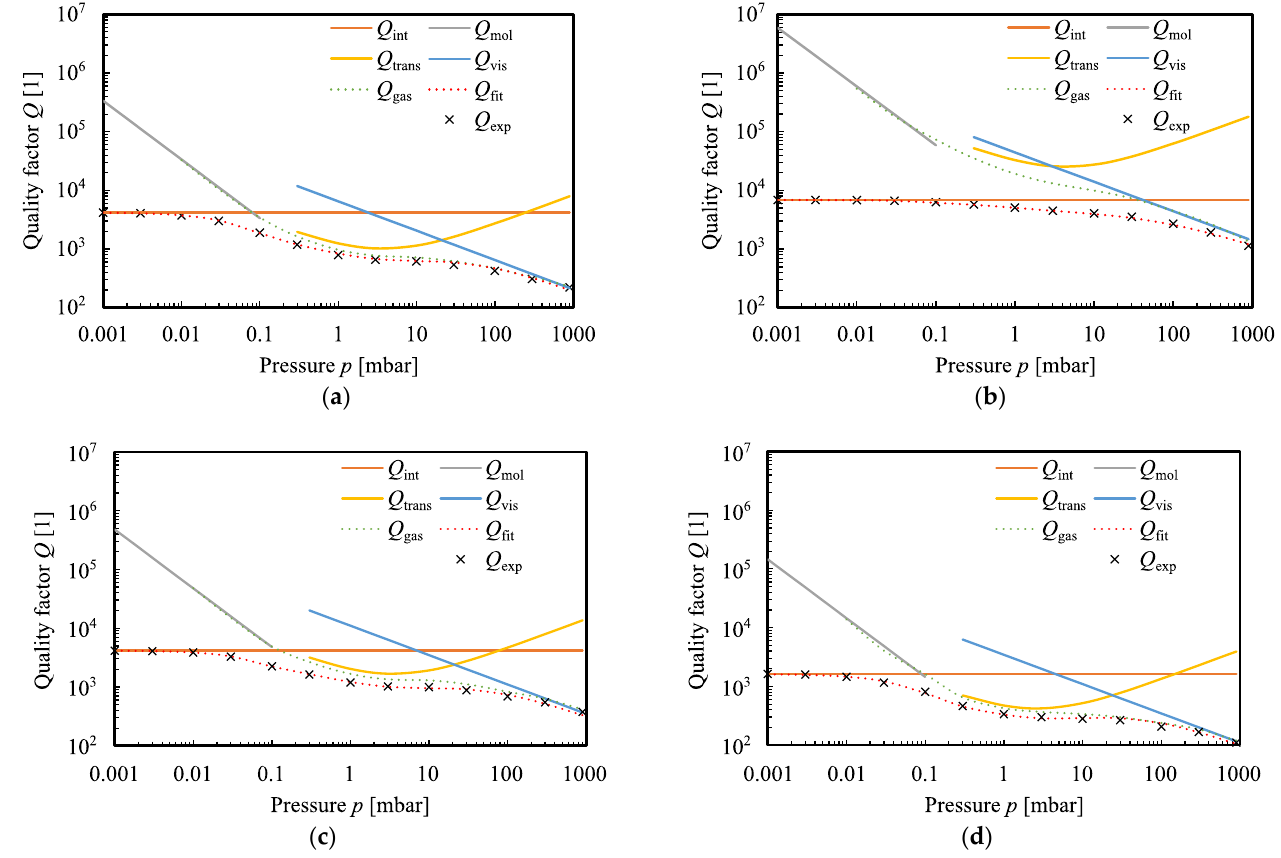
Figure 3. Reconstruction of the experimentally-measured quality factor plot Q exp as function of the ambient pressure. The total quality factor Q fit is composed of the individual damping mechanisms and shows very good agreement over the entire range from molecular to viscous flow regime for the 1st BM ( a ) and for the 3rd BM ( b ) of MEMS oscillator BO3 as well as for the 1st BM of the micro-oscillators PO1 ( c ) and CO1_33 ( d ). The data are measured at a gap width h = 550 µ m in an N 2 atmosphere.